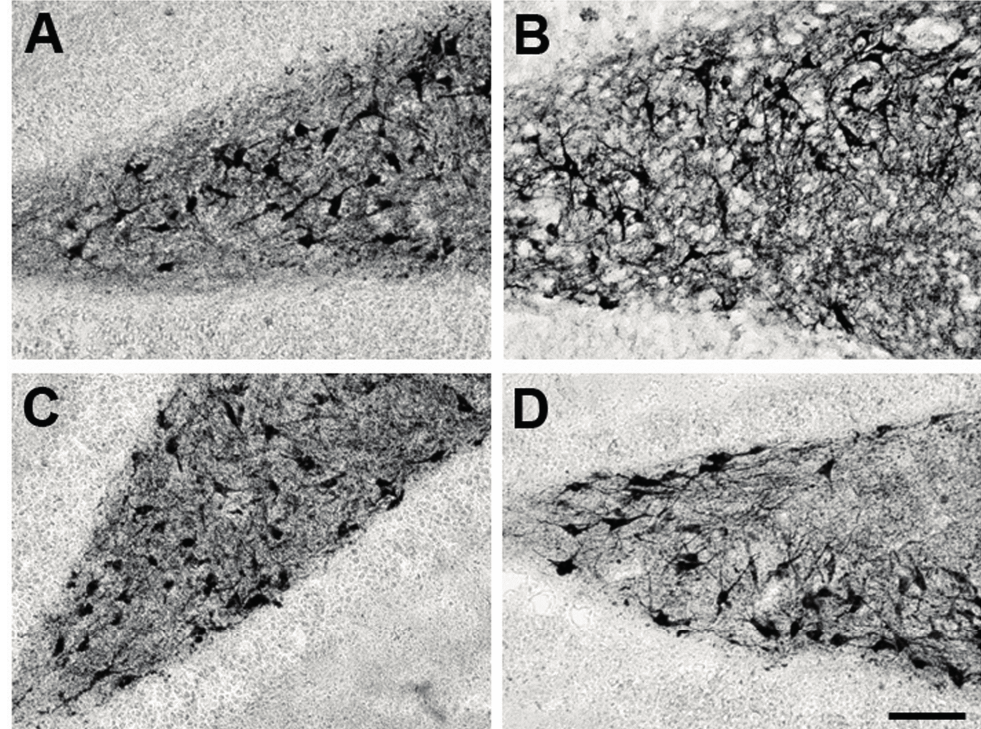
Figure 2. Effect of Protein Kinase C on dendrite formation elicited by